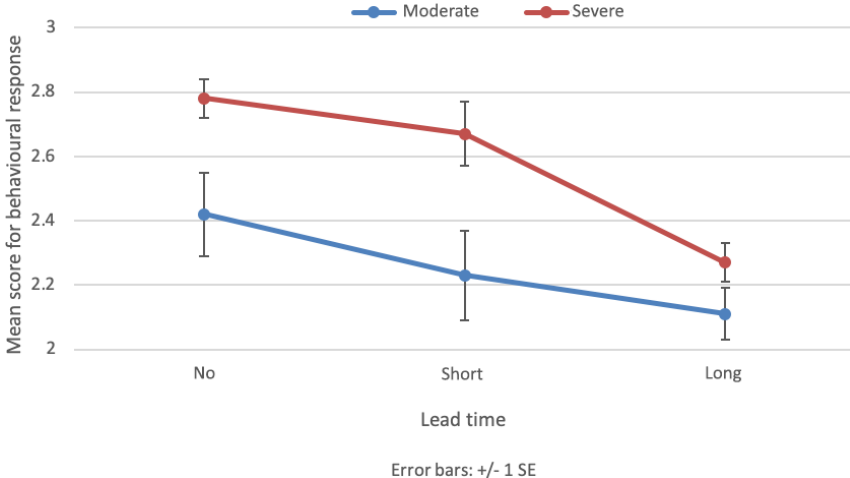
Figure 3. Mean self-reported behavior for all three lead times (no, short and long) and two severity levels (moderate and severe). Behavioral response was measured on a five-point scale from no response to strongest risk-minimizing behavior. For lead times, “no” indicates that respondents considered the warning during the event, “short” refers to 0–6h prior to the event, and “long” refers to more than 6h. Error bars indicate + / − 1 the standard error ( N =